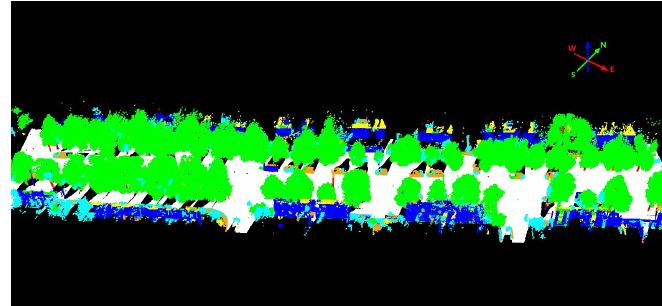
Figure 4. An illustration of result of fusion via constrained CRF However, the training time increased rapidly as well when a bigger test site was applied to train the model. All computations were performed using an eight core CPU of an Intel Xeon E3- 1245 with 3.40GHz. The validation of the training model on a test plot consisting of ca. 25 million MLS points takes one and half